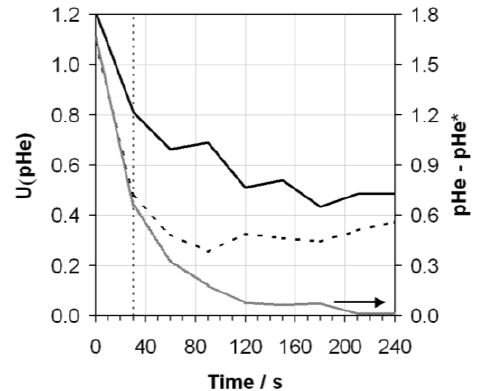
Figure 8. Expanded uncertainty [U(pHe)] (assuming a coverage factor of k = 2, giving a level of confidence of approximately 95%) calculated as a function of time by combining in quadrature the relevant individual components (excluding the contribution of reproducibility between electrodes) for the ASTM method (solid line) and the ASTM method but washing the glass electrode with ethanol prior to measurement (dashed line). The difference between the numerical values obtained using the ASTM method (pHe) and the ASTM method but washing the glass electrode with ethanol prior to measurement (pHe*) are also shown (grey line, right hand axis). The ASTM D6423 specified measurement time is indicated (vertical dotted